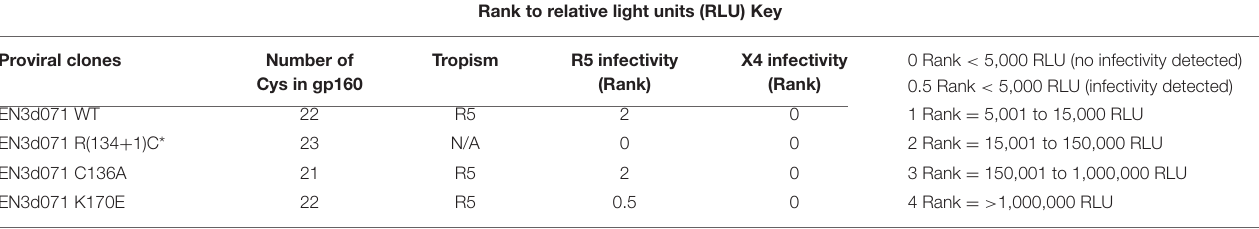
TABLE 4 | Infectivity of wild type and mutant EN3d071